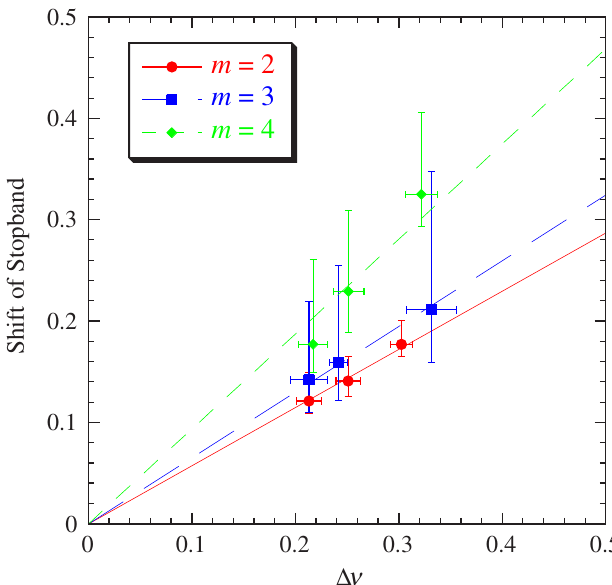
FIG. 13. (Color) Resonance stop bands’ shifts versus rms inco- herent tune shift. The experimentally observed shifts and widths of the three stop bands in Fig. 9 are plotted as a function of the rms incoherent tune shift (cid:2) (cid:4) . The tune depression (cid:6) is estimated by comparing PIC simulation results and experimental data. The vertical bars represent the FWHM of the stop bands. Circles ( d ), squares ( j ), and diamonds ( r ) indicate the locations where the maximum ion loss occurs within the m ¼ 2 , m ¼ 3 , and m ¼ 4 stop bands in Fig. 9.